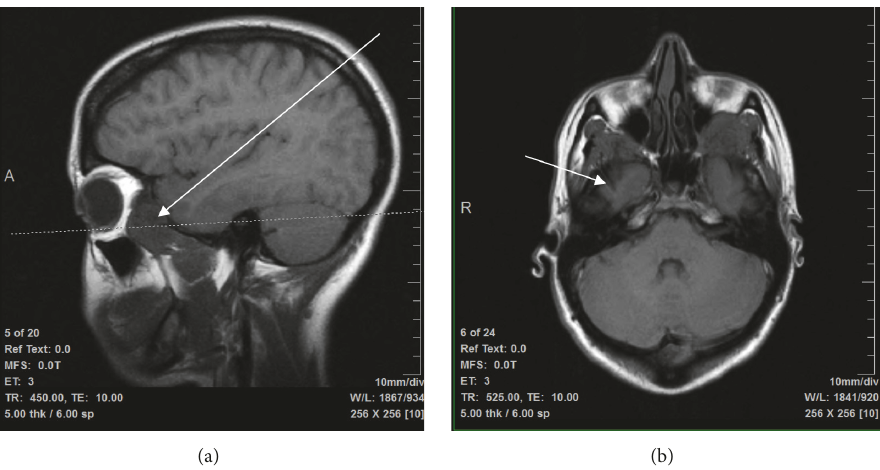
Figure 1: T1 MRI images of malignant PEComa metastasis exerting mass effect in both (a) sagittal and (b) axial views.